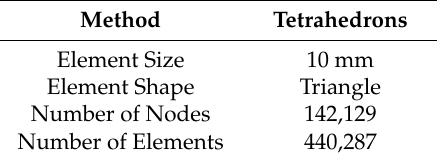
Figure 14. Mesh for heat transfer analysis. Table 8. Mesh properties for heat transfer analysis.